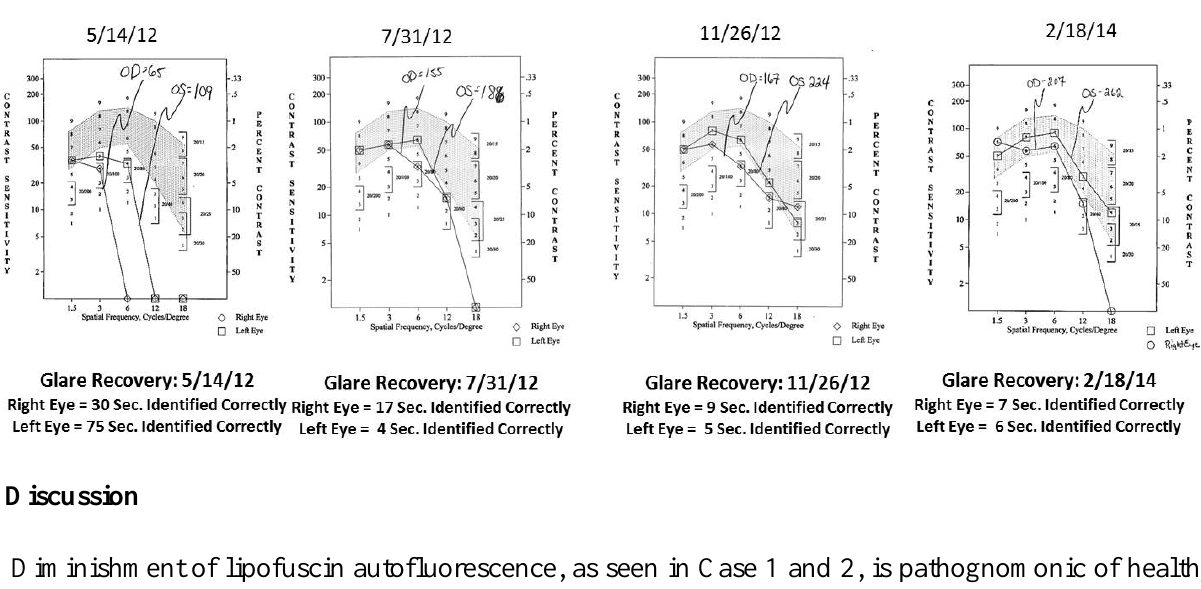
Figure 12. Contrast Sensitivity and Glare Recovery of a 67-year-old male patient with PCV, an AMD variant, and few clinical options. This PCV patient had deteriorated CSF (R 65 AUC, L 109 AUC) at baseline. Normal values are between 200 and 300 AUC. By the second visit, 10 weeks of taking L/RV, the CSF had substantially improved (155 R, 186 L) with continual improvement at the third visit and normalization of each eye by 22 months. The glare recovery quickened dramatically from an abnormal prolonged 30 s right eye and 75 s left eye (normal 10–12 s) at baseline to normal single digit values over the 22-month period. Baseline Snellen visual acuity was 20/25 R, 20/20 L and remained at this level at the second visit. By the third visit at five months, the visual acuity right eye improved to 20/20 and remained unchanged by 22